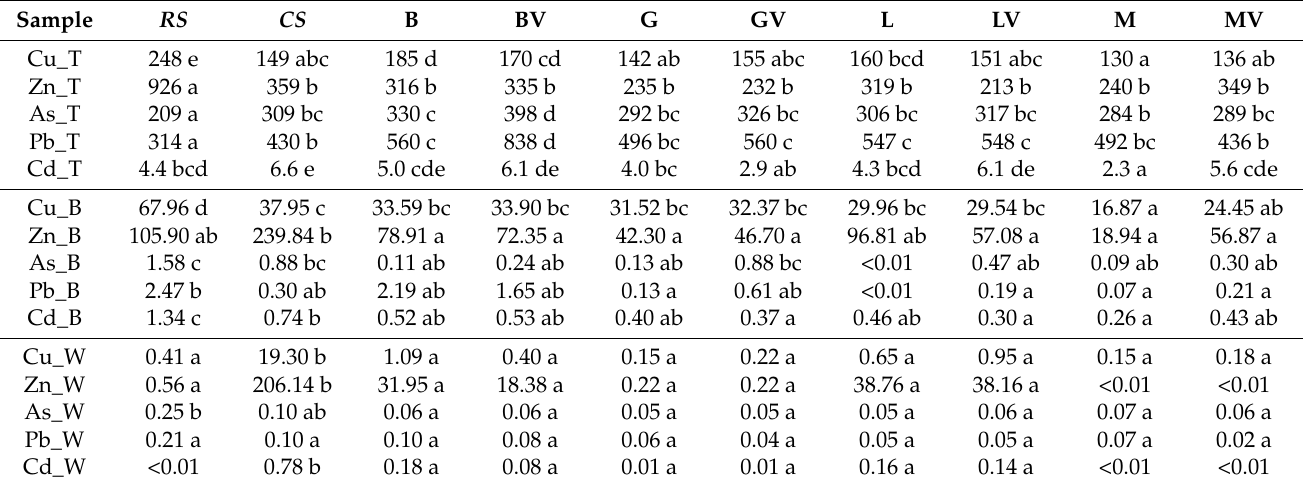
Table 3. The total (Xx_T) soil concentration, the bioavailable concentration (Xx_B), and the water- soluble concentration (Xx_W) of the studied trace elements (Cu, Zn, As, Pb and Cd) for the recovered soil (RS), the contaminated soil (CS), and the different treatments used (see Table 1) one year after field application. Values in mg kg − 1 dry